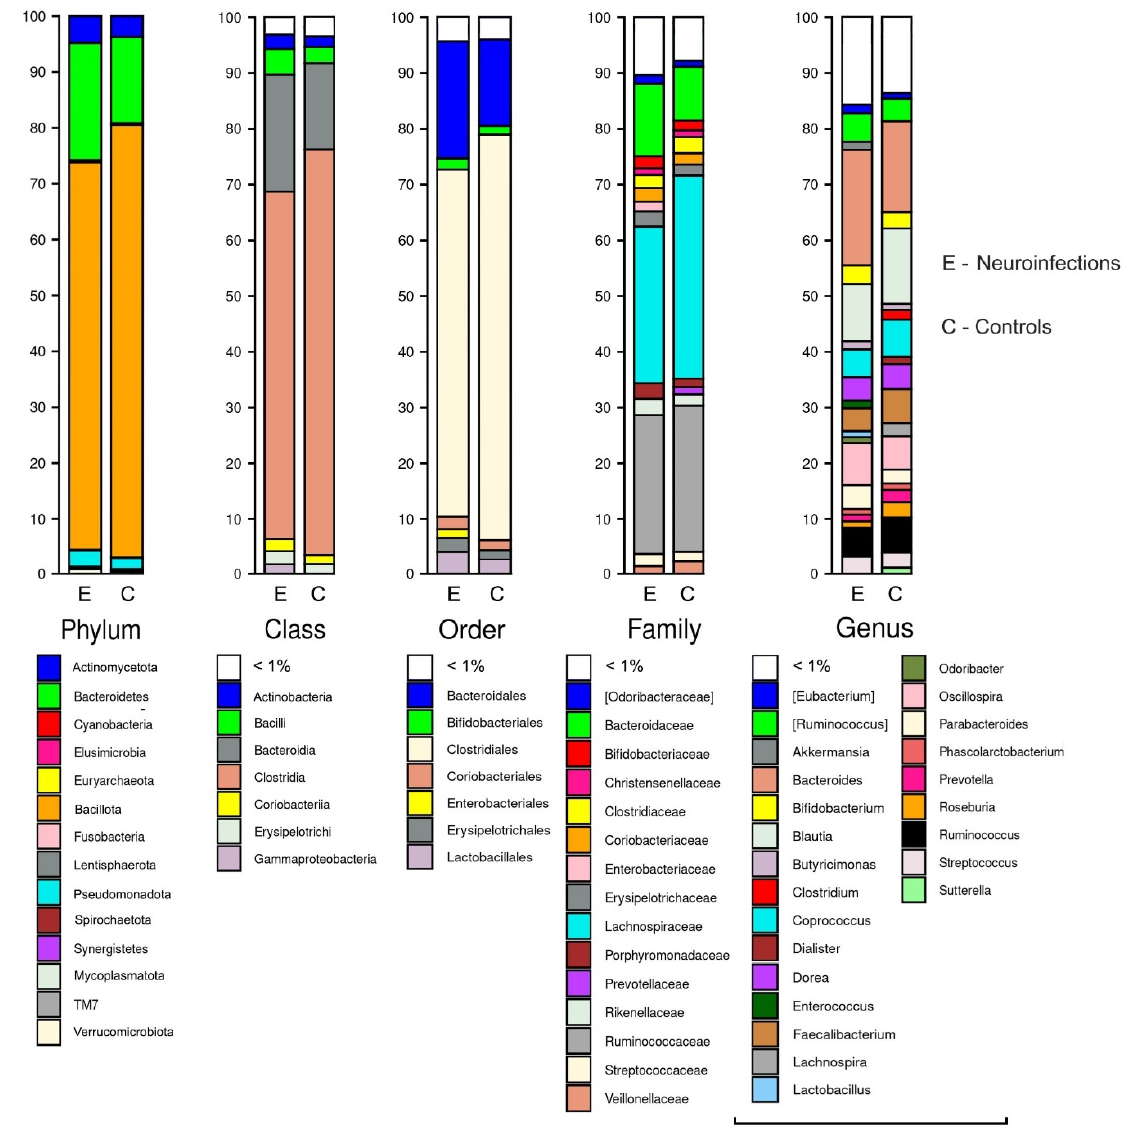
Figure 1. Relative abundance above 1% (all Phylum taxa were visualized) at different bacterial taxonomic levels in patients with neuroinfection and controls.